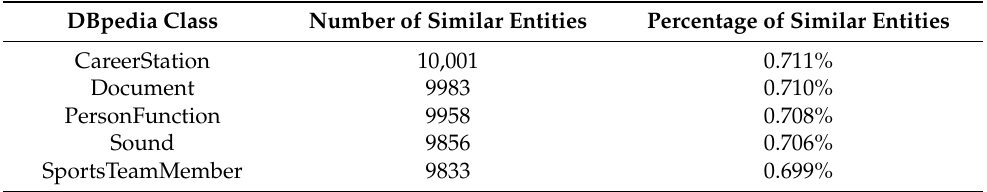
Table 20. DBpedia similar entities based on the whole DBpedia knowledge base.